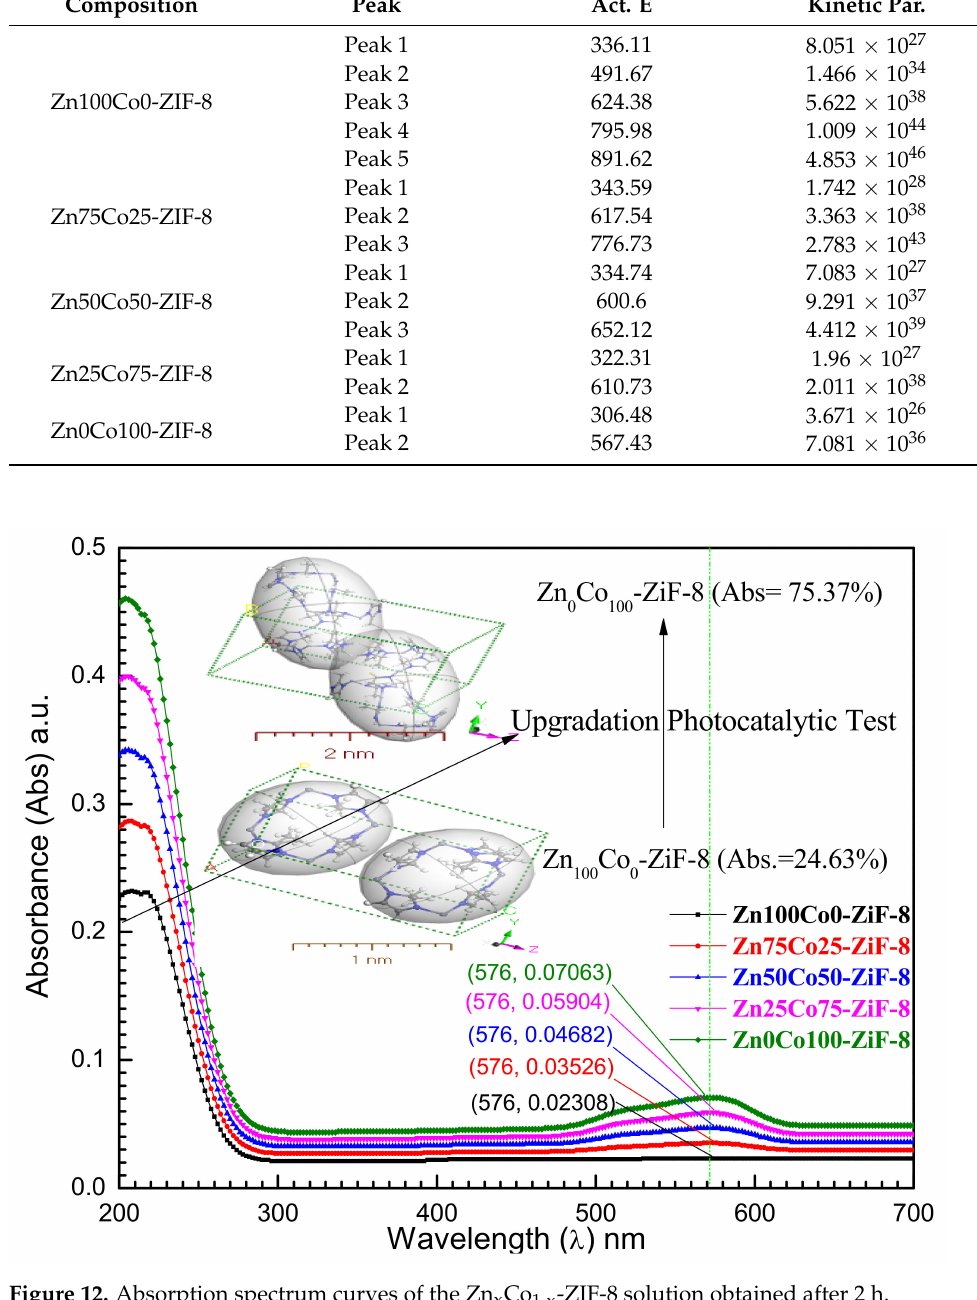
Figure 12. Absorption spectrum curves of the Zn x Co 1-x -ZIF-8 solution obtained after 2